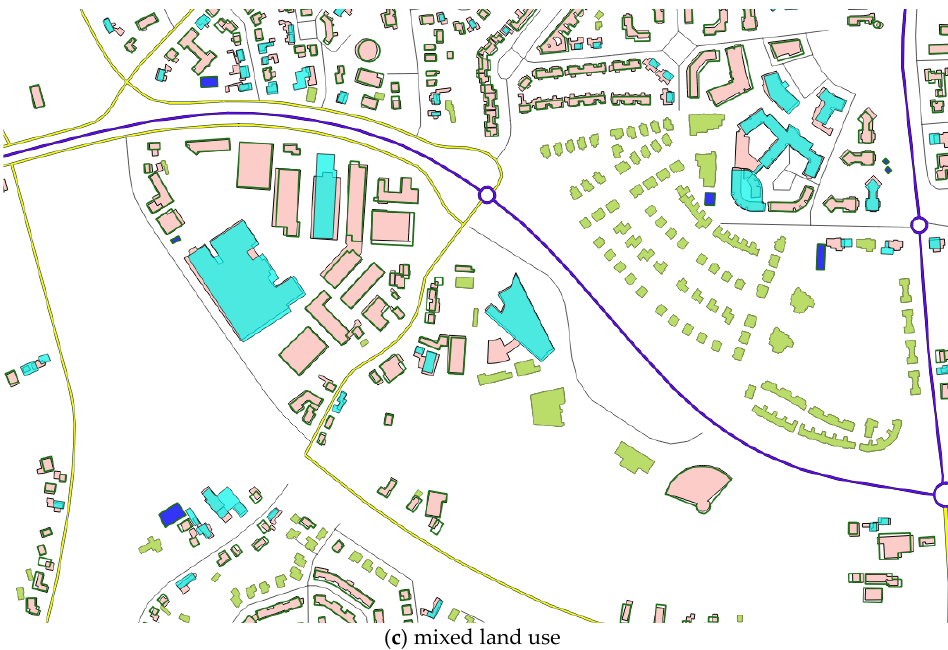
Figure 11. Results obtained by our rule-based approach in ( a ) suburban, ( b ) industrial areas, and an area of mixed land use (TOP10NL is superimposed on OSM data; the status ‘Changed’ indicates that the buildings were modified in part).